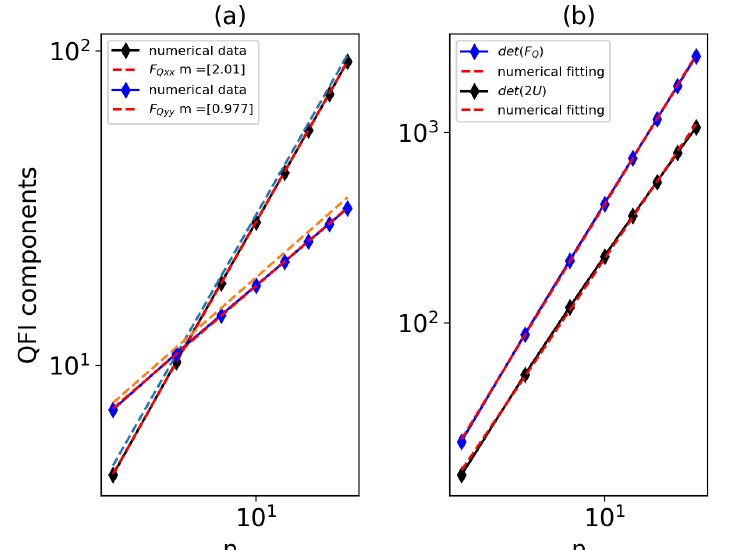
Figure 4: In panel (a) the log-log plot of the diagonal components of the quantum = 0.5 at the critical point. In blue the scaling of the y Fisher information whit h x component, with a slope m = 0.98, and in black that of the x component, with a slope m = 2.01, as a function of the number of spins n . In the log-log plot in panel (b) it is shown in blue the scaling behaviour of the quantum Fisher information matrix = 0.5 as a function of the number of spins n , determinant at the critical point for h x with a slope m = 3.09; in black the scaling behaviour of twice the mean Uhlmann = 0.5, with a slope m = 2.784. In curvature determinant at the critical point for h x panel (a), the blue and orange dashed lines are guides for the eye corresponding to Heisenberg and standard scalings,